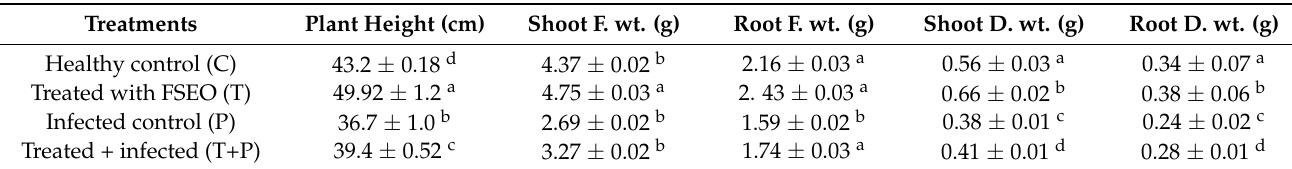
Table 4. Effect of FSEO and F. solani KHA10 on morphological parameters of Vicia faba L. in pot conditions at 6 weeks of